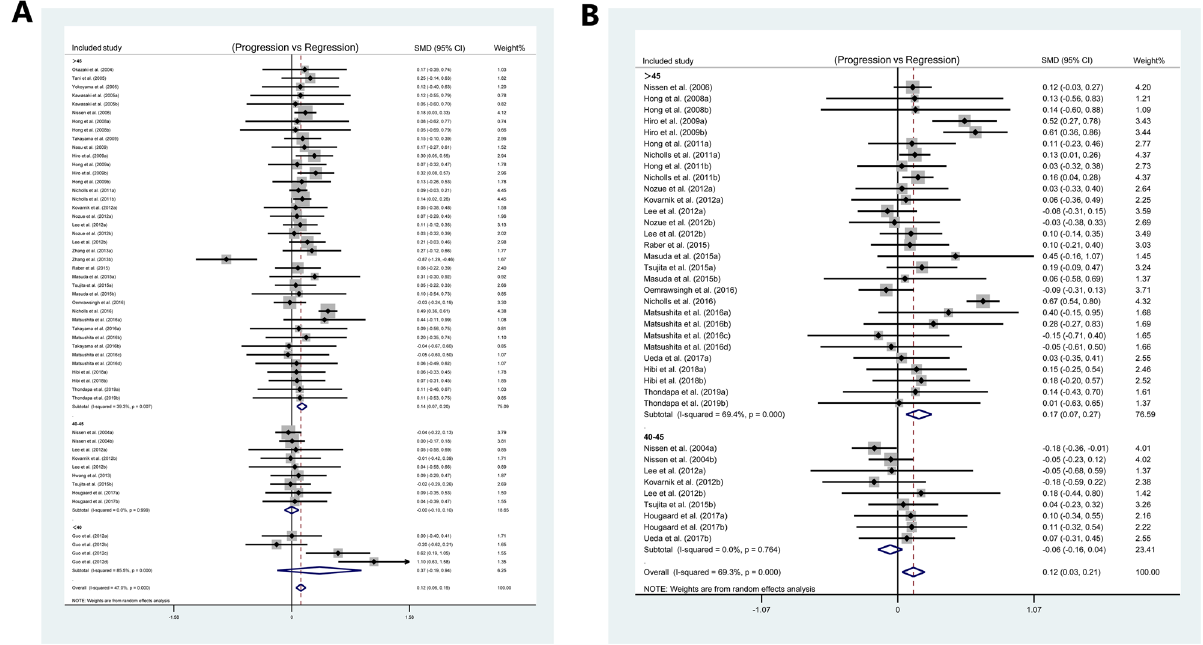
Figure 2. Subgroup analysis for SMD in plaque volume between patients at baseline and follow-up: ( A ) subgroup analysis of TAV according to the different levels of HDL; ( B ) subgroup analyses of PAV according to the different levels of HDL.